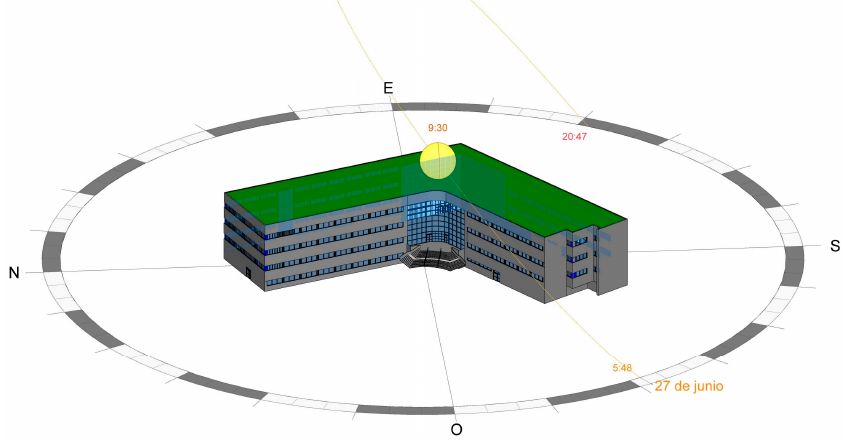
Figure 5. Revit model of the EIF (northwest façade).